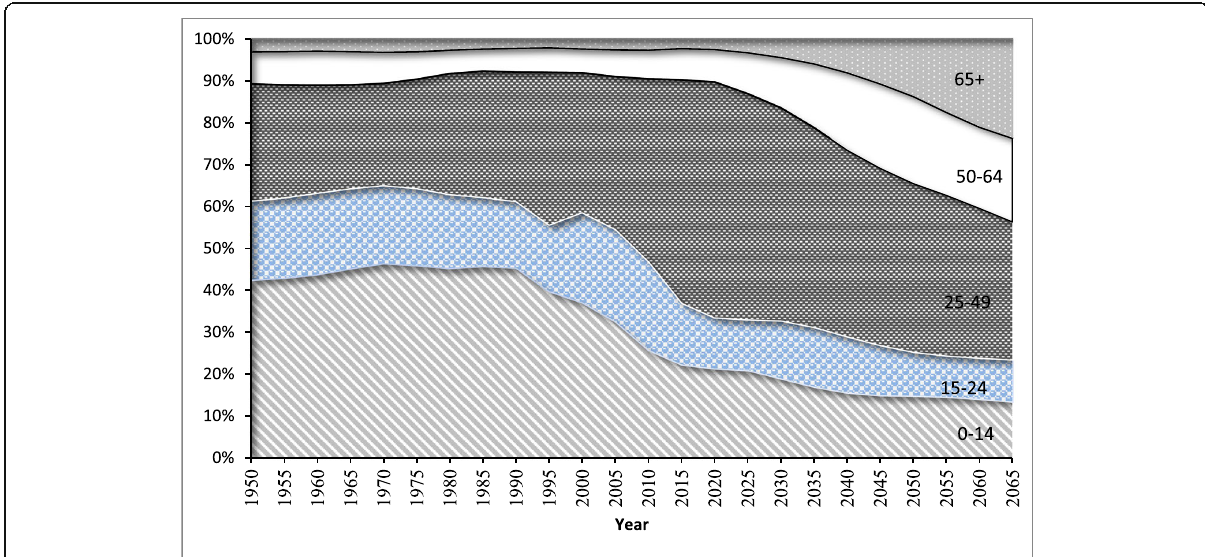
Fig. 6 Age structural transition in Oman 1950 – 2065. Source: UN population estimates and projection